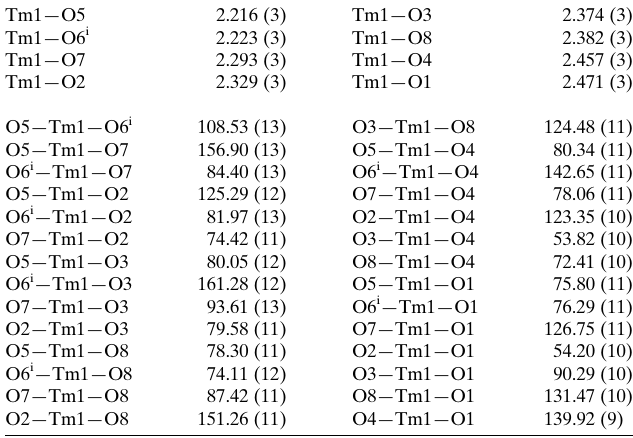
Table 1 Selected geometric parameters (A˚ , (cid:3) ).